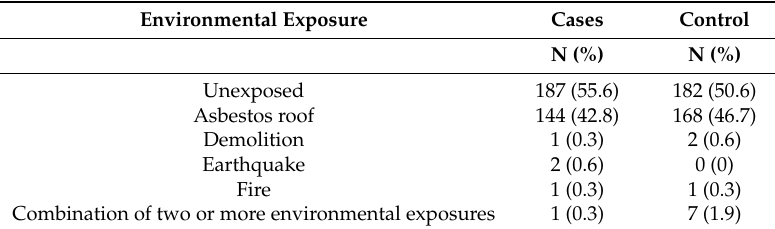
Table 3. Distribution of environmental